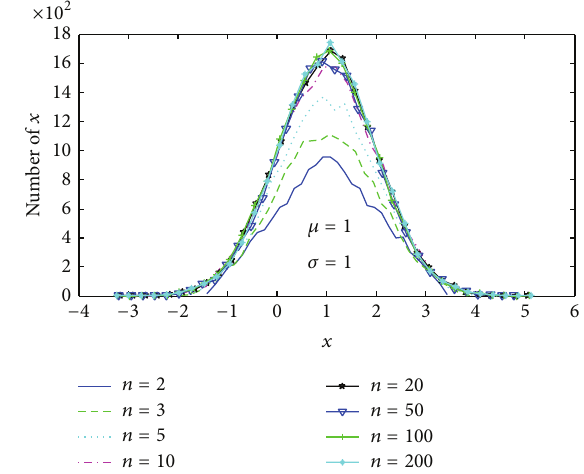
Figure 2: Cartogram of sampling